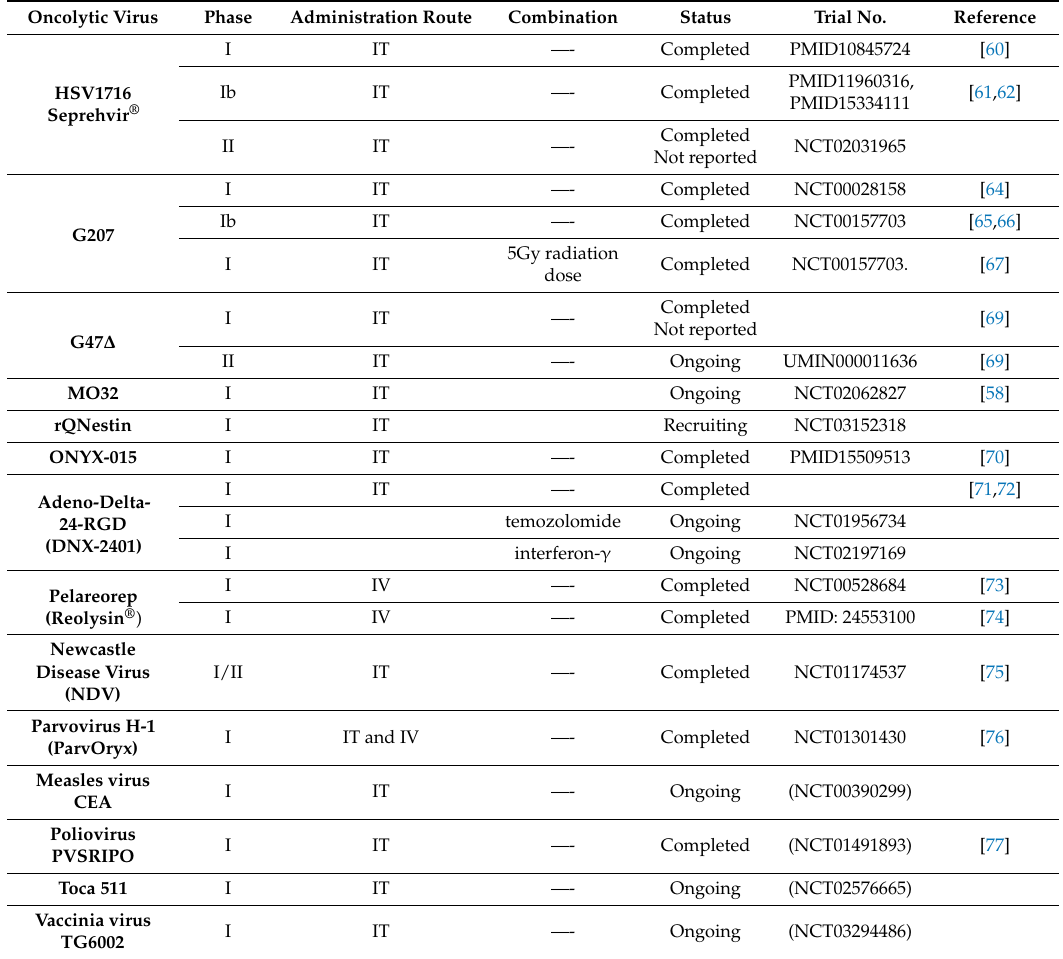
Table 3. The clinical trials of oncolytic viruses in patients with